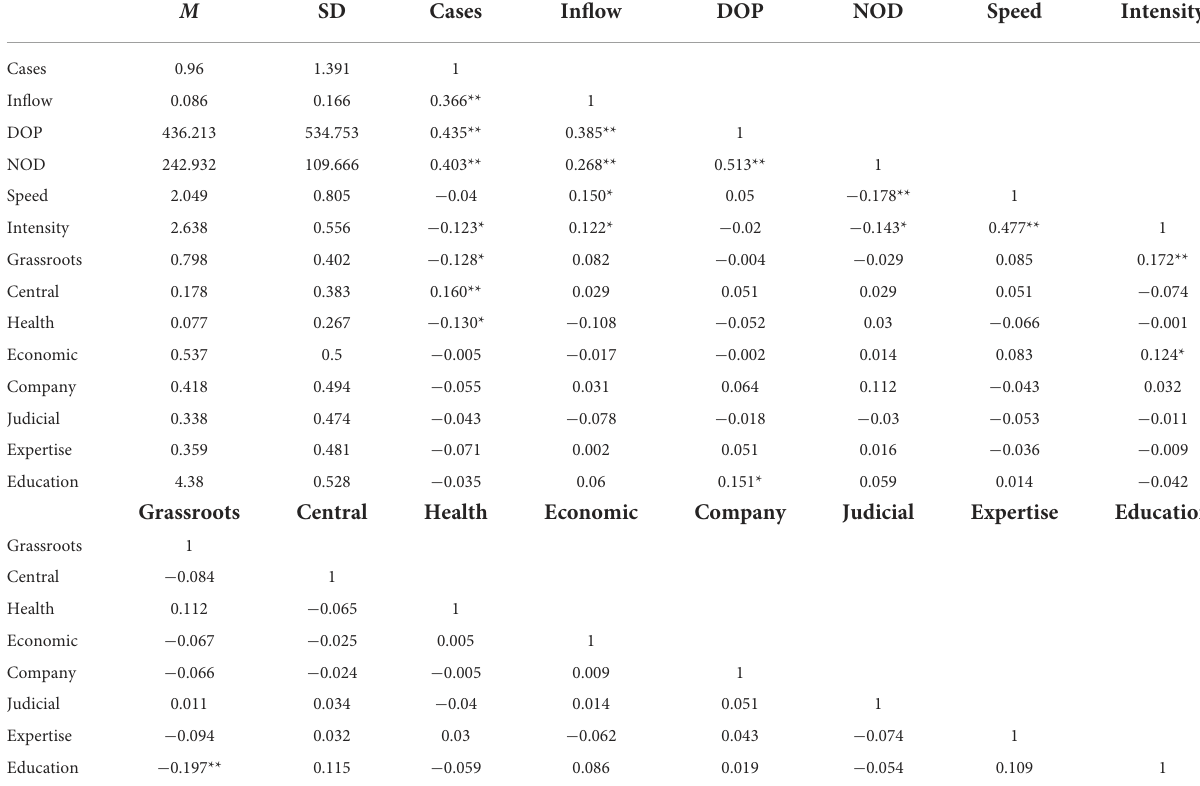
TABLE 1 Descriptive statistics of variables related to pandemic